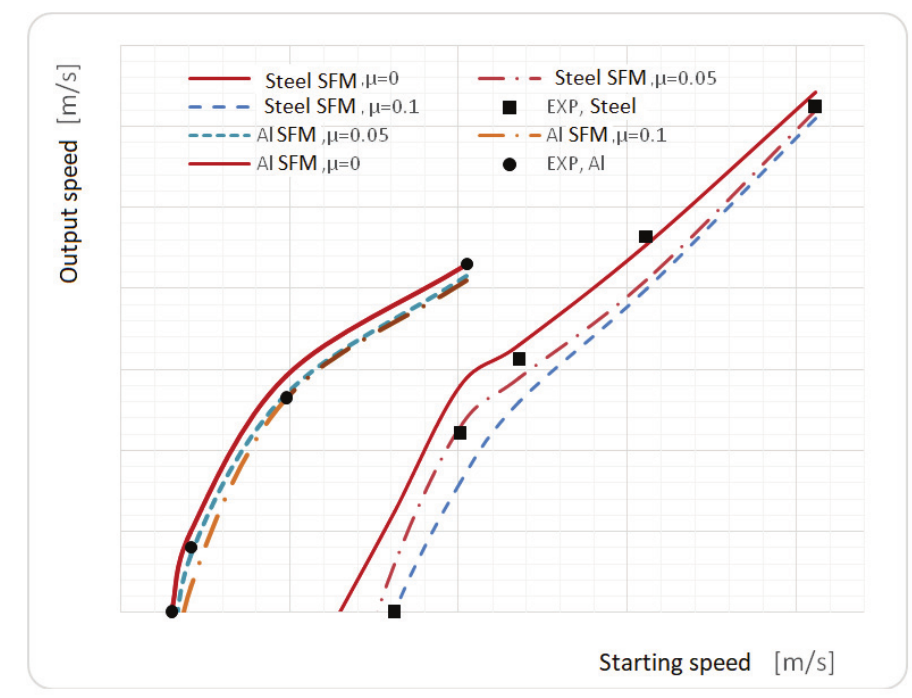
Figure 5 – Friction effects in the perforation of a 12 mm thick steel plate and s 15 mm aluminum panel by conical